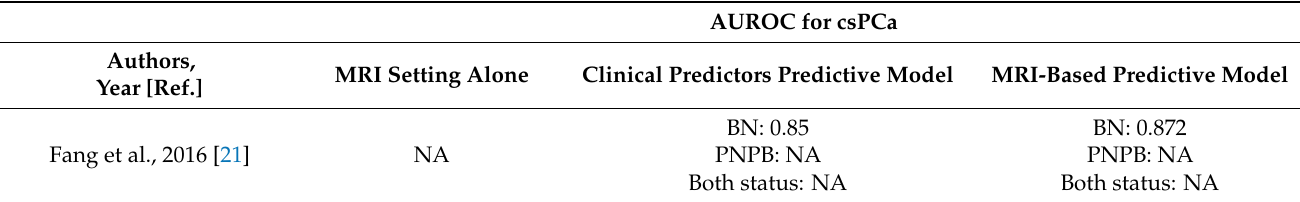
Table 4. AUROCs for MRI setting alone, PM based only in clinical predictors and MRI-based PMs. AUROC for